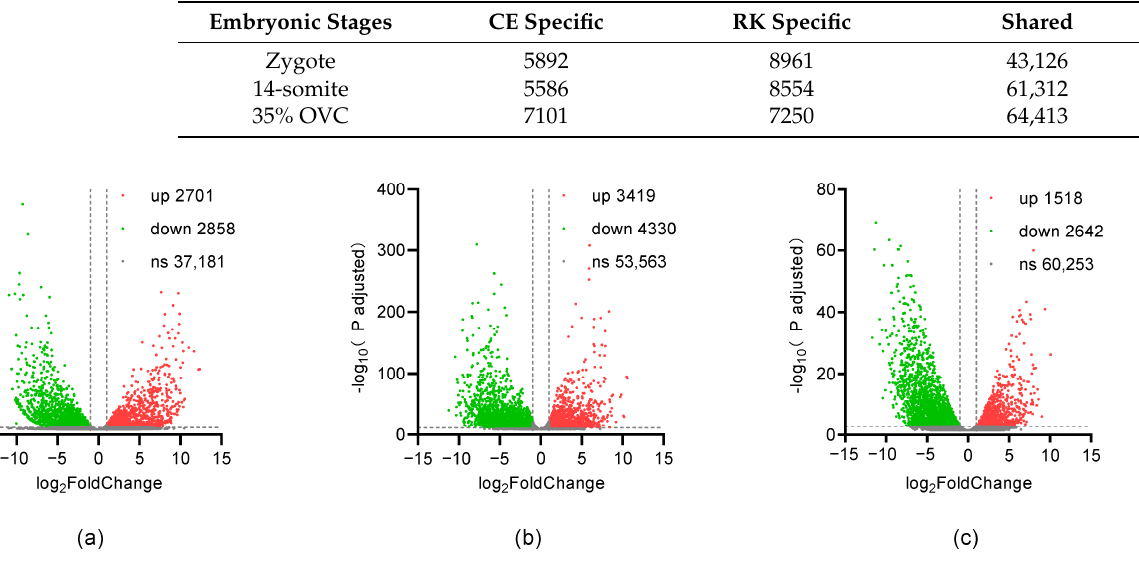
Table 3. Breed specific gene expression at different embryonic stages.